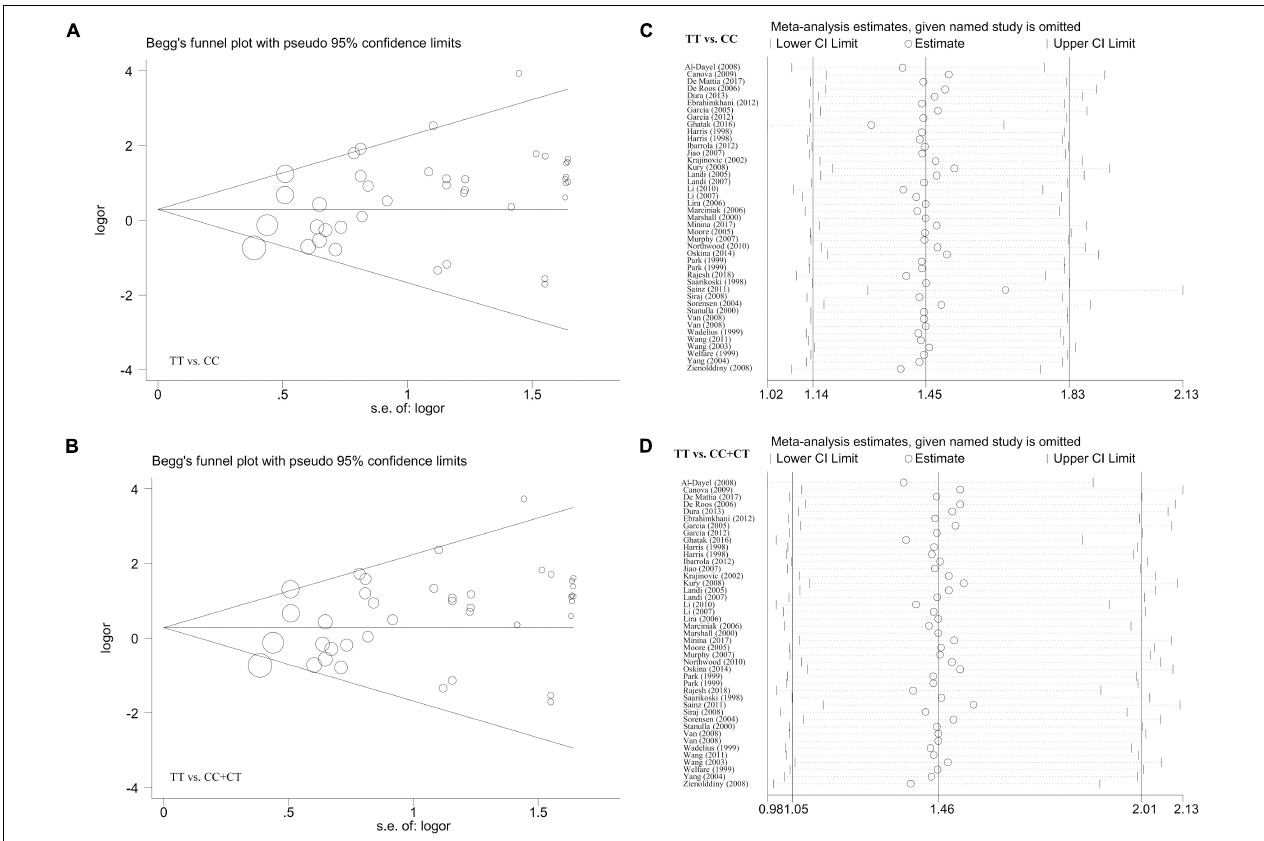
FIGURE 4 | The publication bias plot according to the Begg’s test and the sensitivity analysis data for the overall population under the models of TT vs. CC and TT vs. CC+CT. (A,B) Begg’s test; (C,D) sensitivity